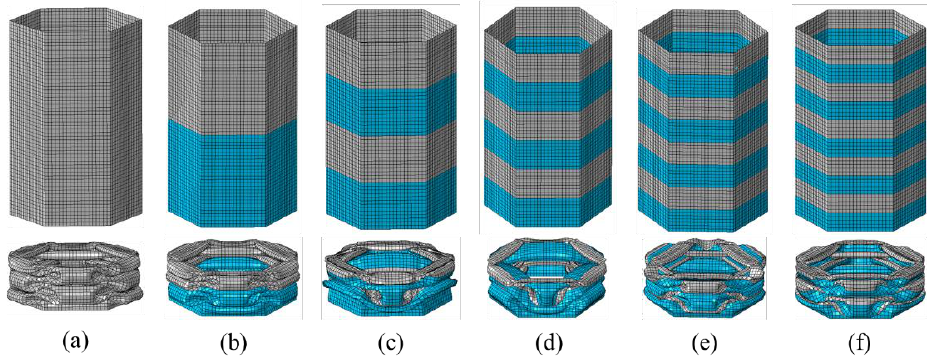
Figure 12. Ultimate deformation modes for models with even circumferential stripes: ( a ) UT; ( b ) LNT-2; ( c ) LNT-4; ( d ) LNT-6; ( e ) LNT-8; ( f ) LNT-10.